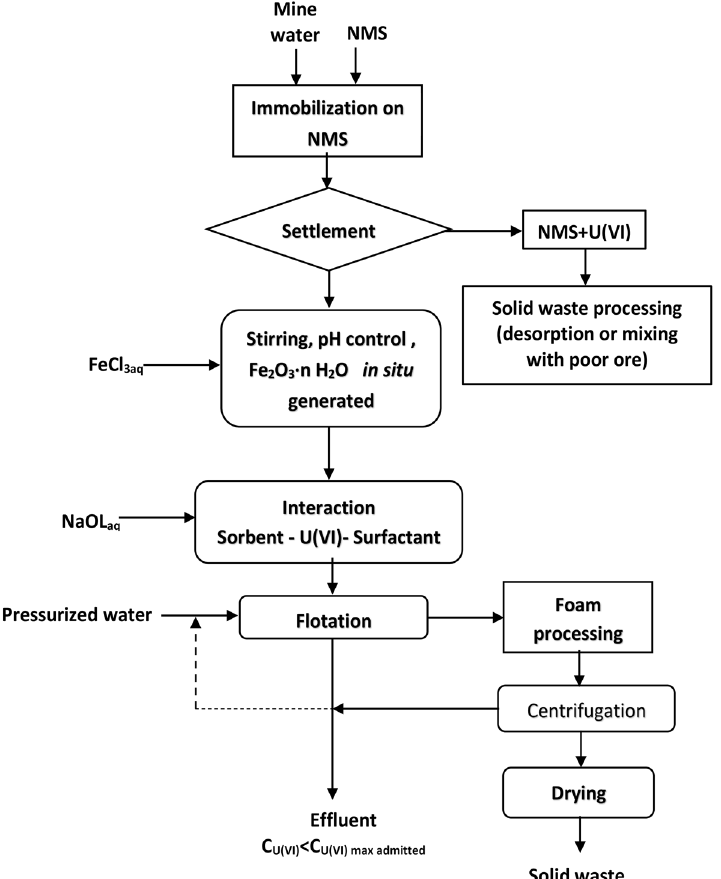
Figure 15. Immobilization and flotation where for pH adjustment 0.1 M FeCl 3 solution is used, which is the reagent for sorbent in situ